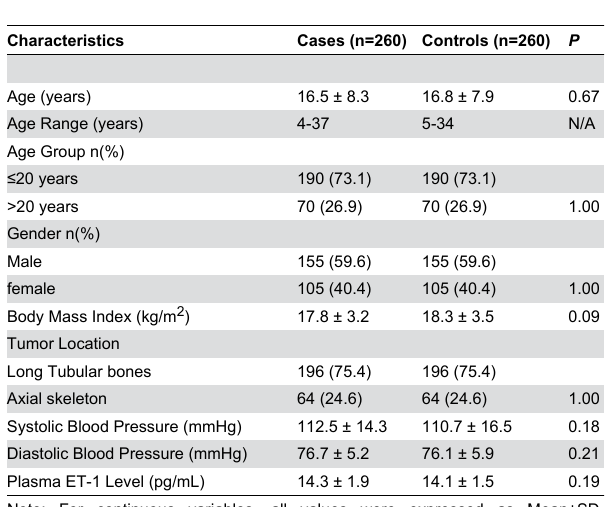
Table 1. Characteristics of study